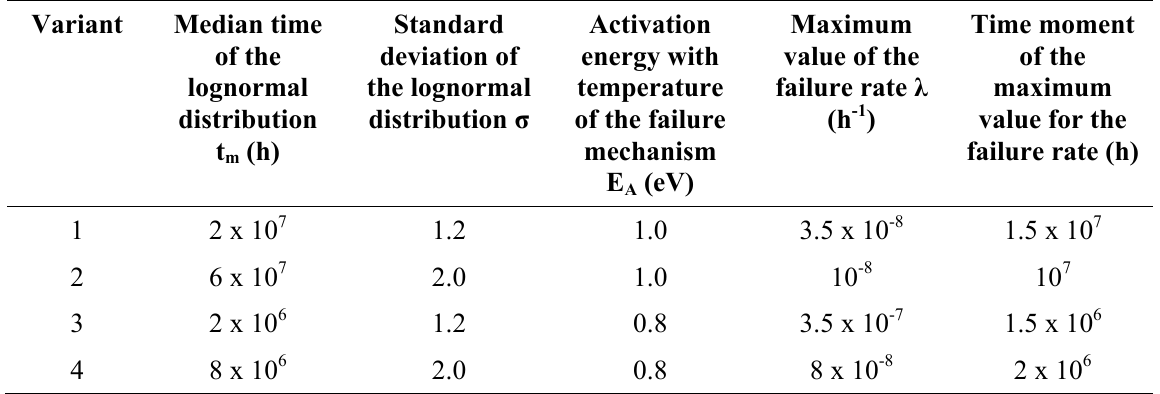
Table 5. Maximum value of the failure rate vs.